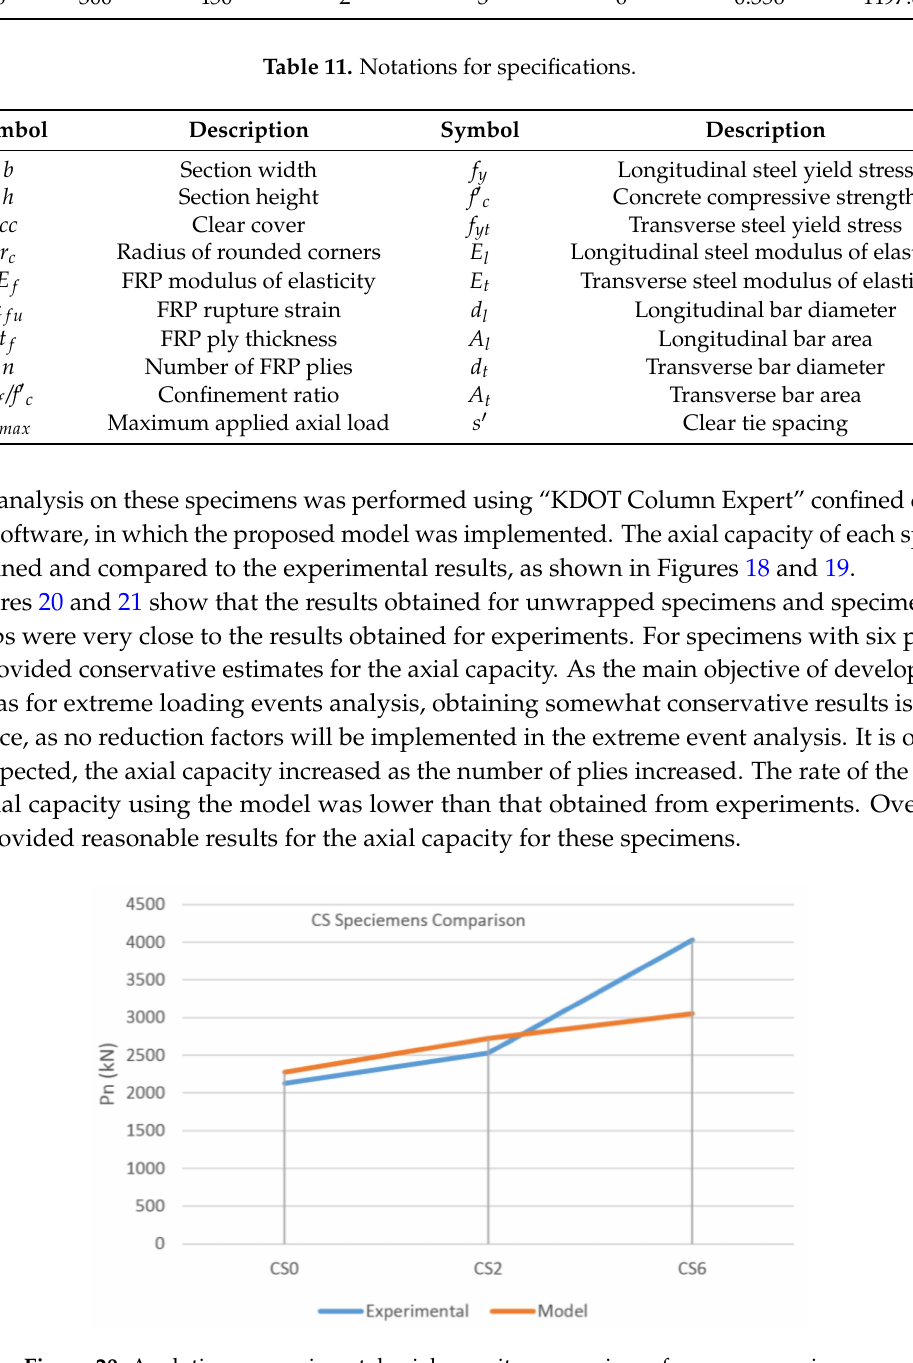
Figure 20. Analytic vs. experimental axial capacity comparisons for square